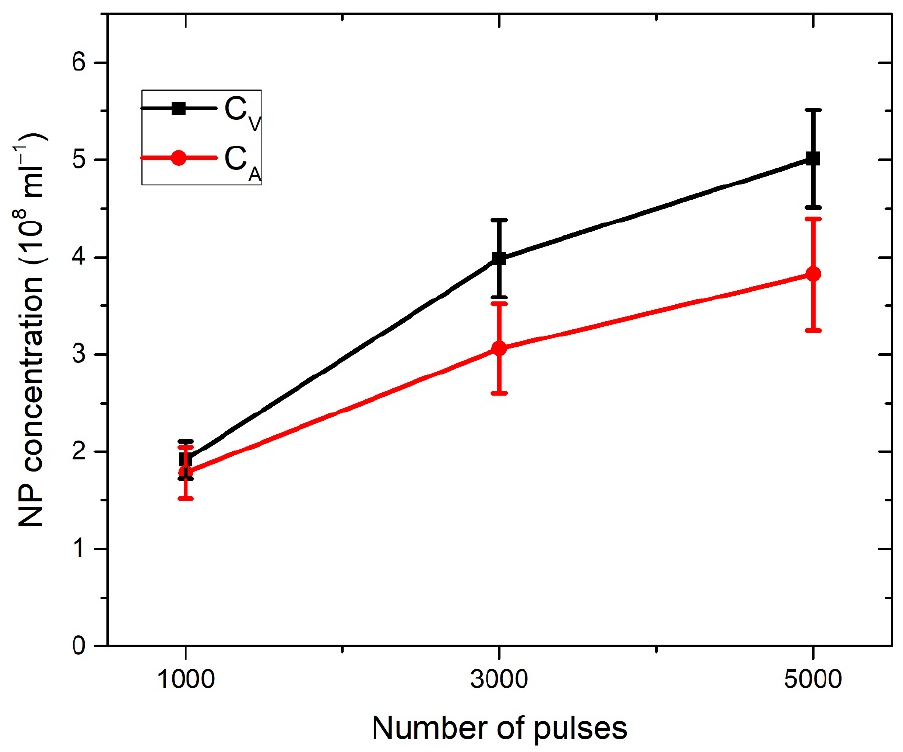
Figure 7. Dependence of TiO 2 concentration on a number of pulses for two different ways of concentration calculation using crater volume ( C V ) or the Beer–Lamber law ( C A ).